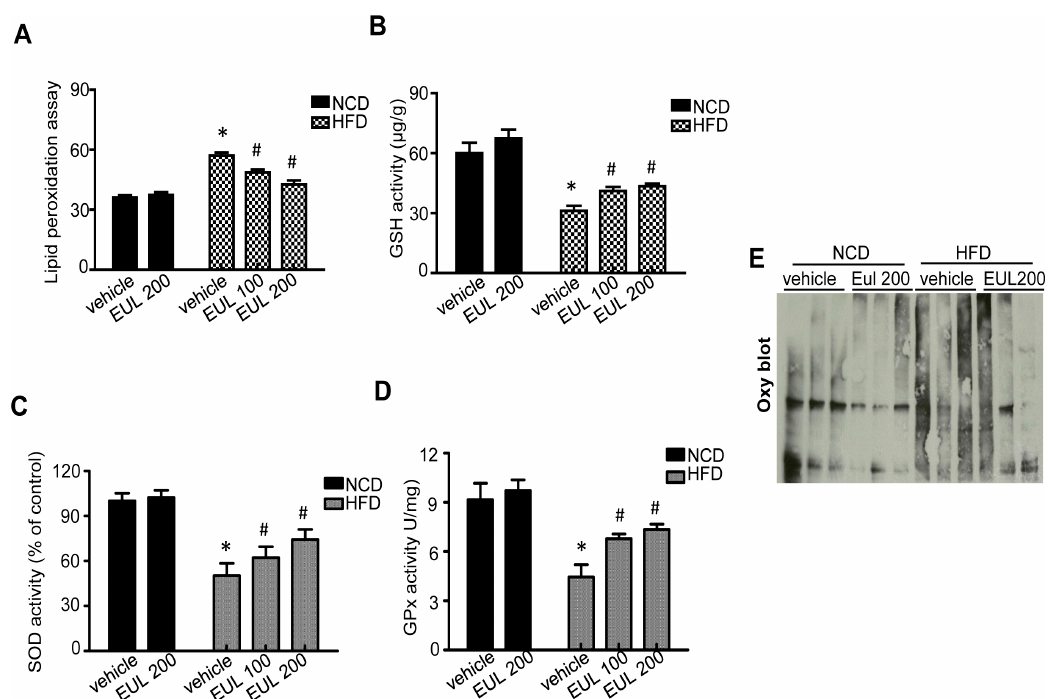
Figure 5. EUL regulates antioxidants in hyperlipidemic rats. Experimental scheme. Rats were fed a HFD for 6 weeks, were given 100 mg/kg or 200 mg/kg EUL for 8 weeks, and were then sacrificed. Liver MDA ( A ) and GSH ( B ) levels. SOD ( C ) and GPx ( D ) activity levels. ( E ) Oxidized protein in liver-tissue lysates was assessed by an OxyBlot assay. Values are means ± SDs. ( n = 6, * p < 0.05 versus NCD group, # p < 0.05 versus HFD group). NCD, normal chow diet; HFD, high-fat diet; EUL, Eucommia ulmoides leaf; MDA, malondialdehyde; SOD, superoxide dismutase; GPx, glutathione peroxidase; GSH, glutathione; Oxy; oxidized